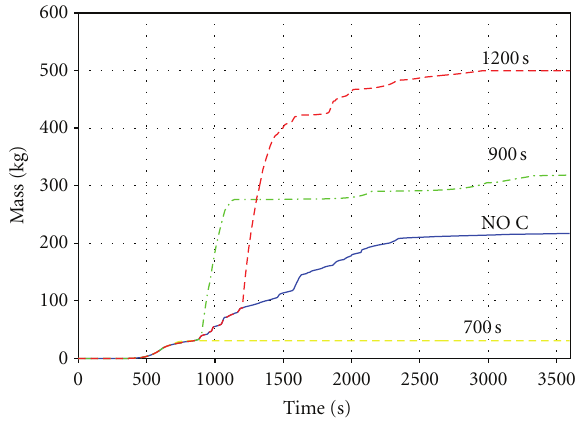
Figure 8: Core total hydrogen generation (kg). HPCS injection to 700 s, 900 s, and 1200s; NO C indicates without HPCS injection.